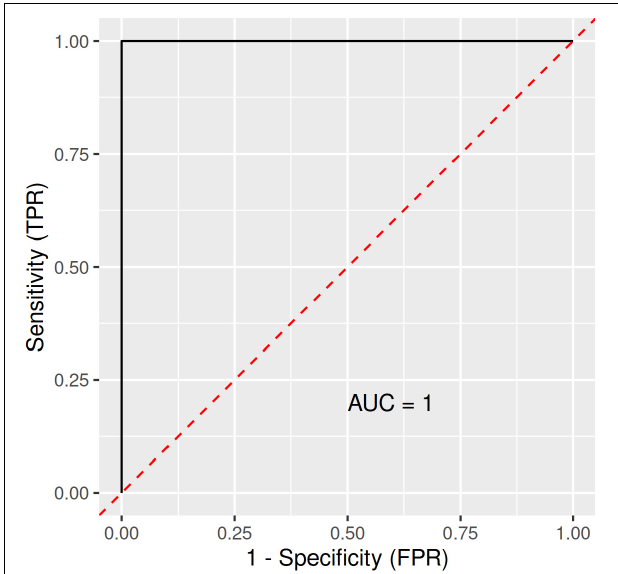
FIGURE 1 | ROC (receiver operating characteristic) curves with an area under the ROC curve (AUC) for the RFM-L algorithm with VO2max, fat content, and BMI as joint predictors/discriminators between LA and CTRL groups. FPR, false-positive rate; LA, lifetime elderly endurance athletes; CTRL, controls; RFM-L, random forest machine-learning; TPR, true positive